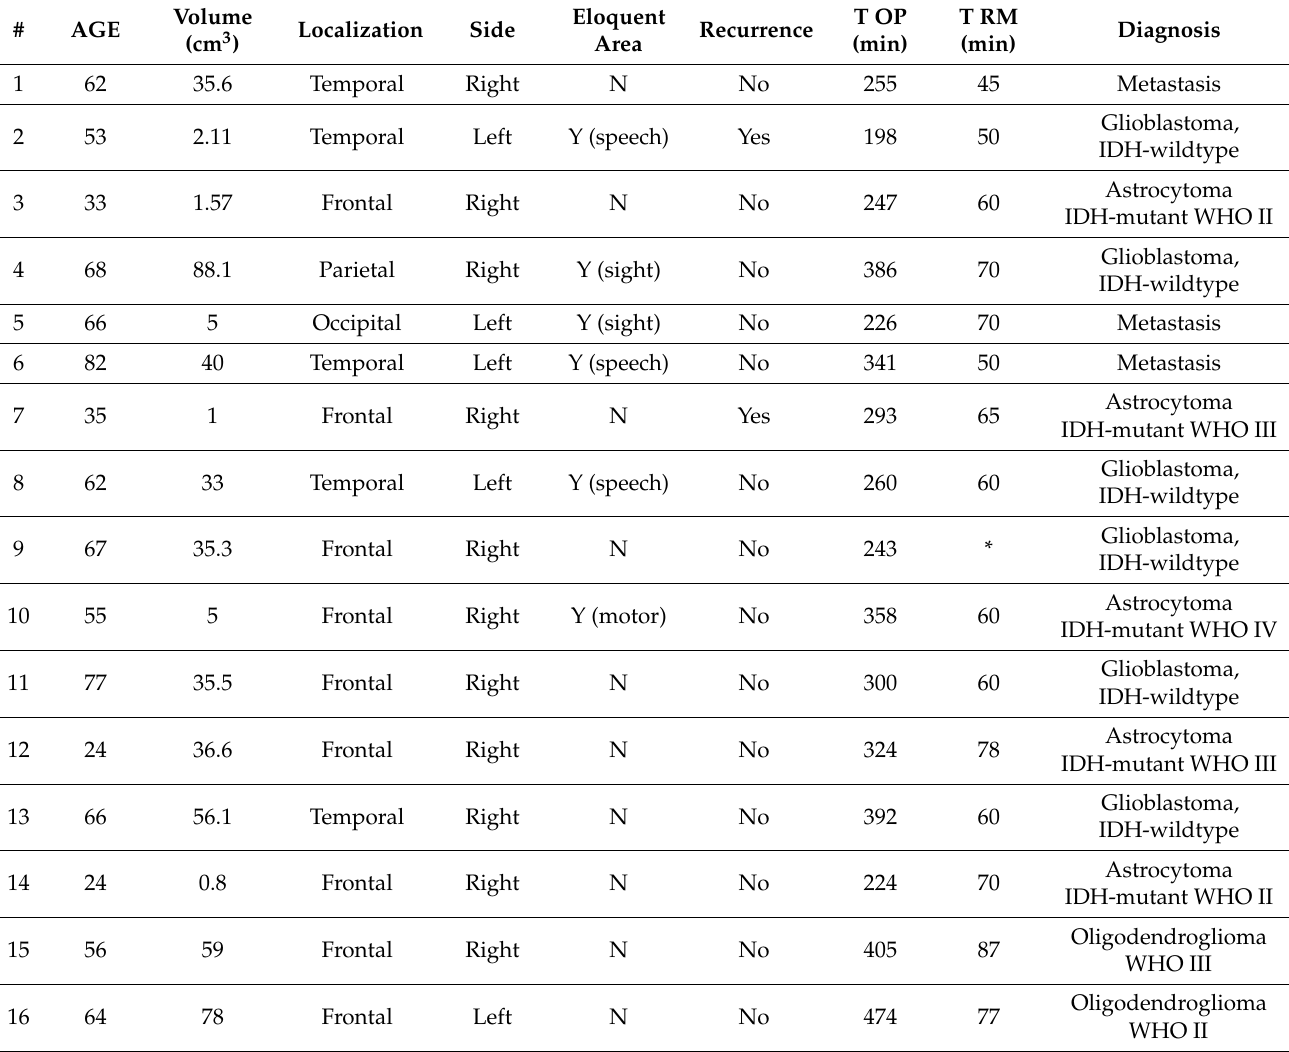
Table A1. Summary of patient descriptive data; * = missing